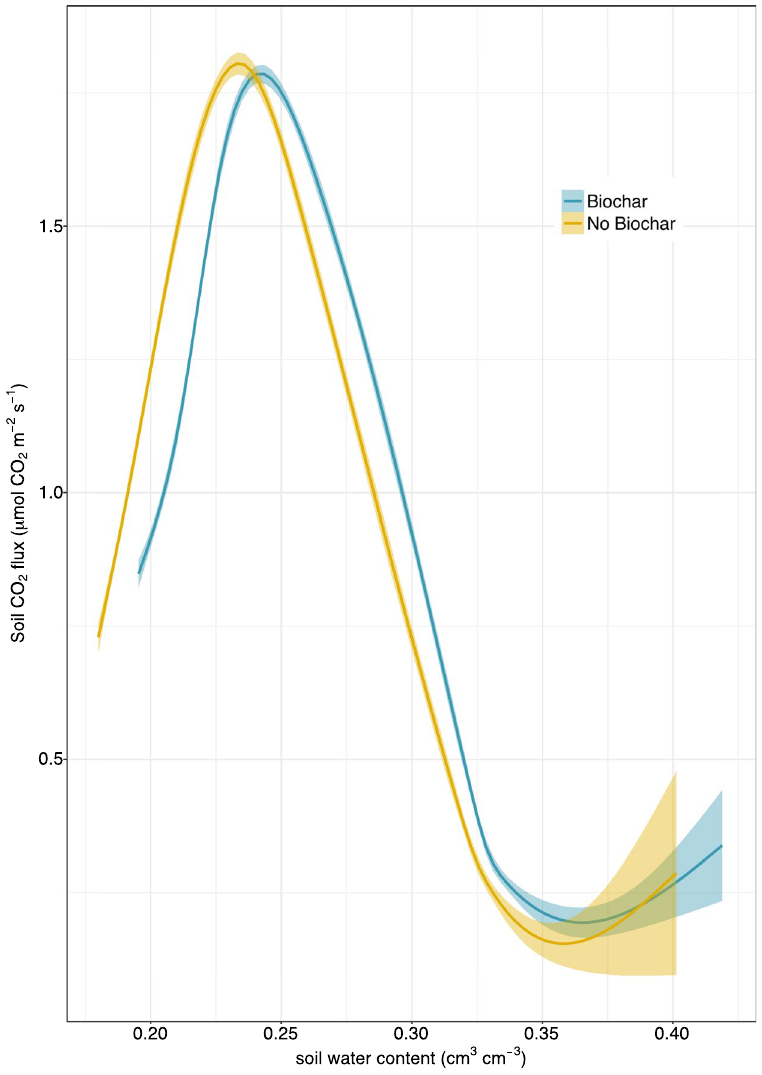
Figure 4. Soil CO 2 effluxes as a function of soil water content for Biochar and No Biochar